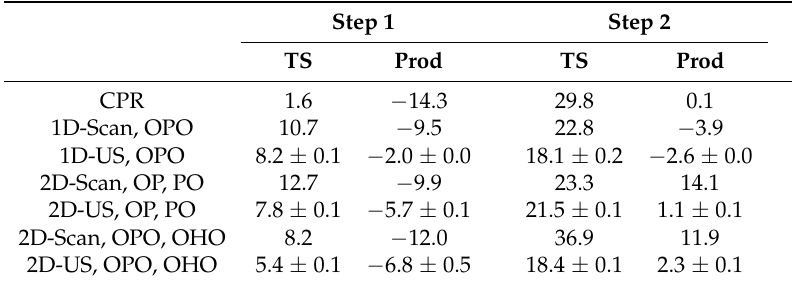
Table 1. Energies of transition (TS) and product (P) state along Step 1 and Step 2 of the phospho- hydrolysis reaction in PSP, computed with conjugate peak refinement (CPR), one- and two-dimensional potential energy scans, and by one- and two-dimensional umbrella sampling (US). Energies are relative to the intermediate state (IM) from which the phosphate transfer starts (1IM2 in the CPR-computed pathway for Step 1, Figure 5 and 2IM1 in the CPR-computed pathway of Step 2, Figure 7). OPO refers to the linear combination of P–O distances ([d(Ser-OG–P) − d(P–O-Asp11)] for Step 1 and [d(P–O-Asp11) − d(wat-O–P)], for Step 2), OHO to the linear combination of O–H distances ([ − d(Ser-OG–H)